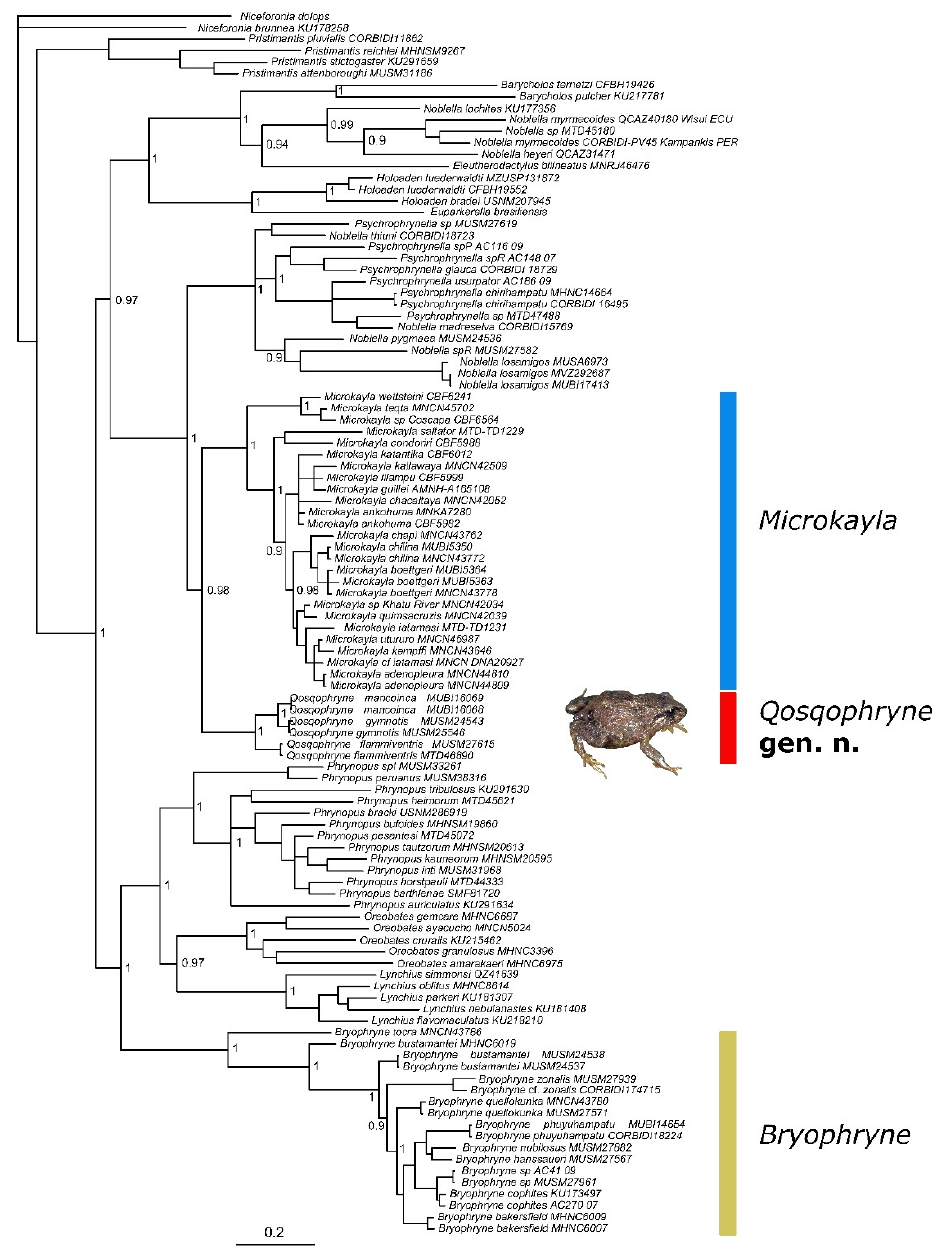
Figure 2. Bayesian maximum clade-credibility tree for 106 species of Holoadeninae (Terrarana) based on a 2646-bp concatenated partitioned dataset (fragments of genes 16S, 12S, COI, RAG1, and Tyr), highlighting the relationships of the three genera Bryophryne , Microkayla and Qosqophryne gen. n. Posterior probabilities are indicated at each node. The frog illustrated here is Qosqophryne gymnotis , paratype MUSM 24542 (photograph by A. Catenazzi).